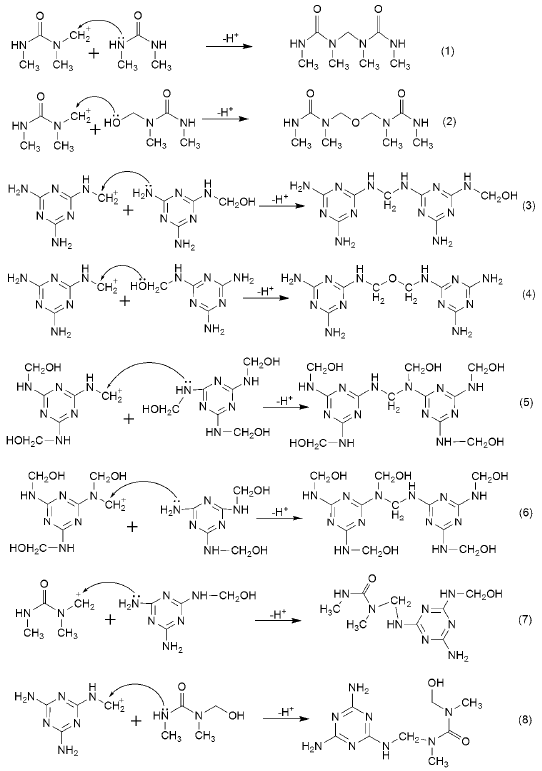
Figure 5. The representative acid-catalyzed condensation reactions.